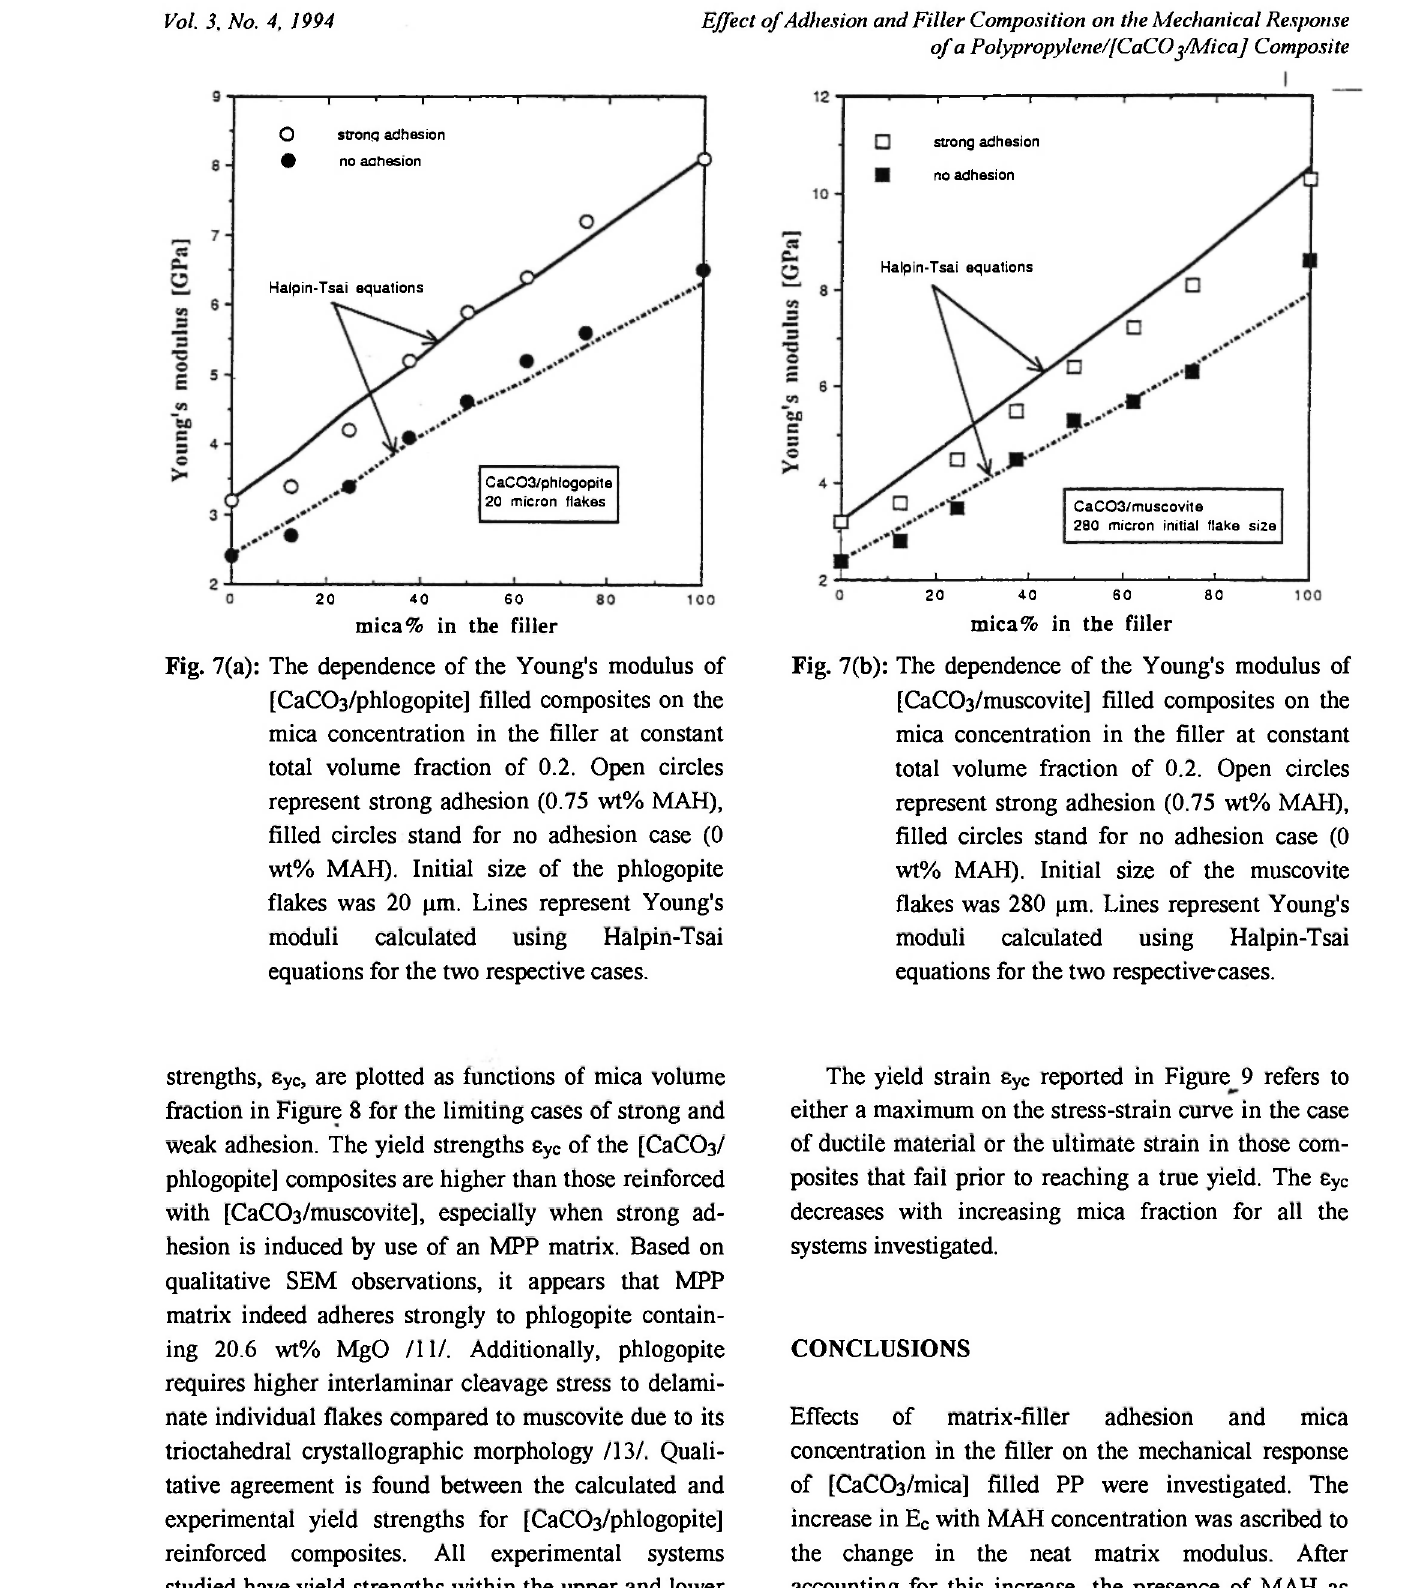
Fig. 7(a): The dependence of the Young's modulus of [CaCCVphlogopite] filled composites on the mica concentration in the filler at constant total volume fraction of 0.2. Open circles represent strong adhesion (0.75 wt% ΜΑΗ), filled circles stand for no adhesion case (0 wt% ΜΑΗ). Initial size of the phlogopite flakes was 20 μπι. Lines represent Young's moduli calculated using Halpin-Tsai equations for the two respective cases.